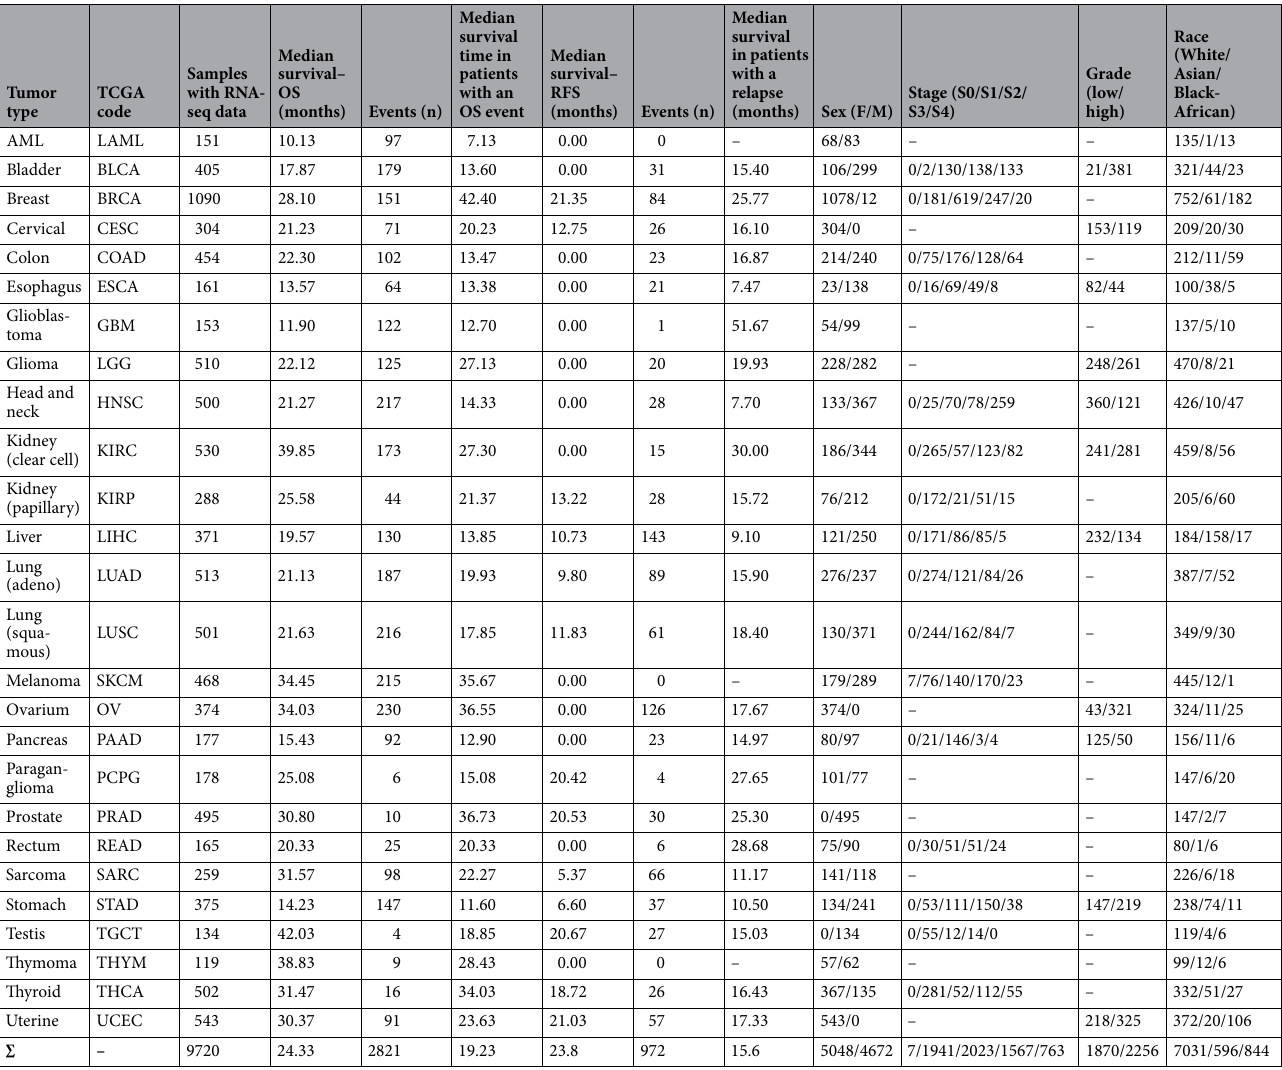
Table 1. Clinical characteristics of